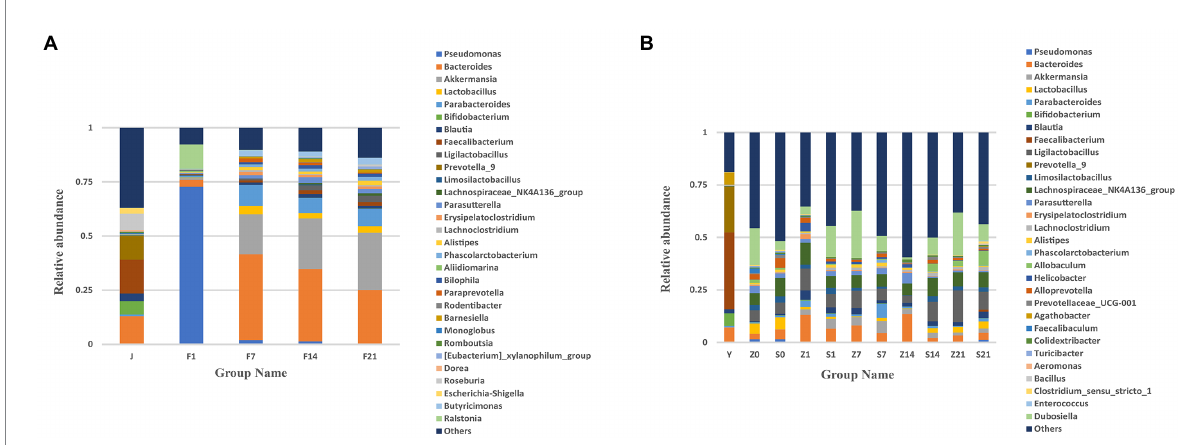
FIGURE 1 Bar chart of relative abundance of gut microbial composition at the genus level. (A) Bar chart of the relative abundance of gut microbial composition at the genus level of GF mice; J, human-derived mixed gestational fecal fluid; F, FMT arm; (B) Bar chart of the relative abundance of gut microbial composition at the genus level of SPF mice; Y, human-derived mixed gestational fecal fluid; Z, control arm; S, FMT arm; For all the pictures: 0, before gavage of antibiotics; 1, after gavage of antibiotics, 1 day before FMT; 7, day 7 of FMT; 14, day 14 of FMT; 21, day 21 of FMT. FMT, fecal microbiota transplantation; GF, germ-free; SPF, specific pathogen